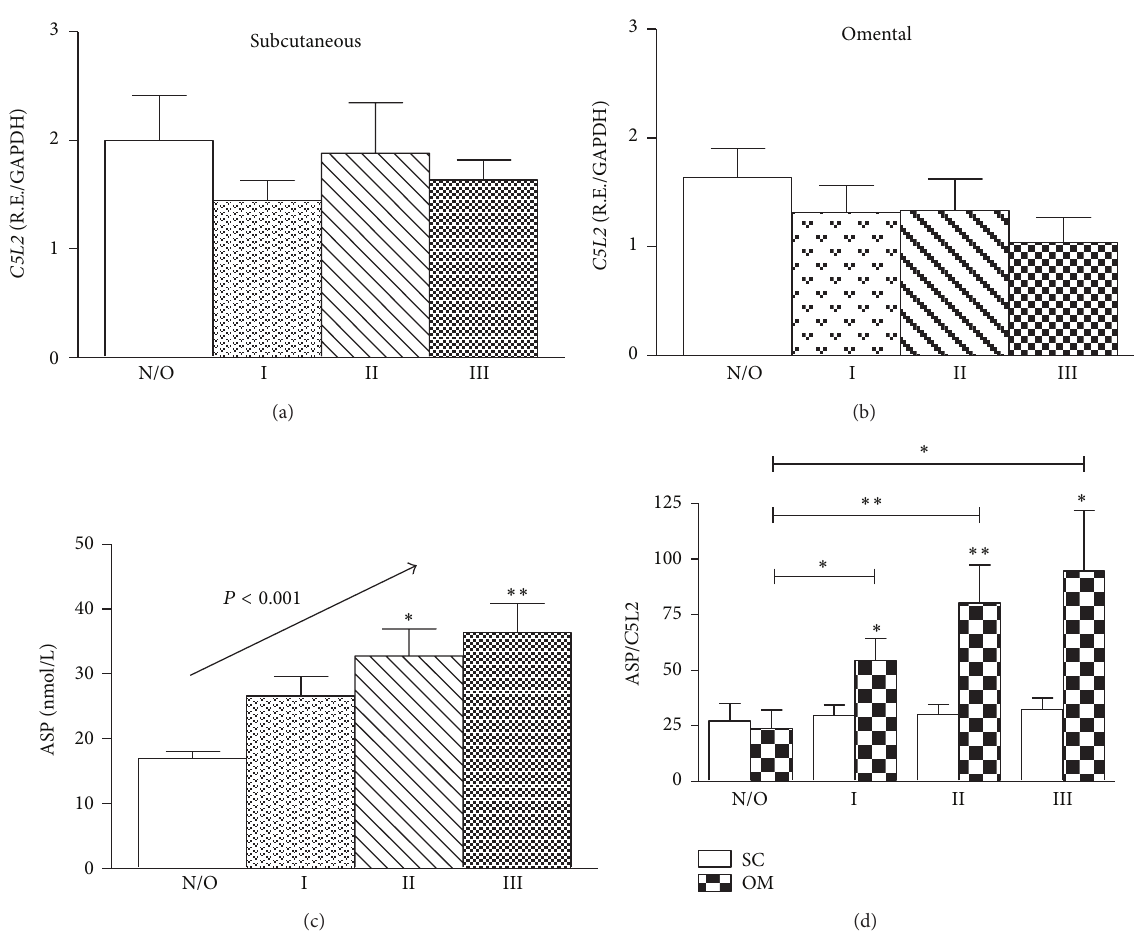
Figure 1: Circulating ASP and ASP to C5L2 ratio are associated with adiposity. Subcutaneous (a) and omental (b) C5L2 mRNA expression for normal/overweight (open bar), obese group I (dotted bar), obese group II (striped bar), and obese group III (checkered bars), (c) plasma ASP for normal/overweight (open bar), obese group I (dotted bar), obese group II (striped bar), and obese group III (checkered bars), and (d) ASP/ C5L2 ratio in subcutaneous adipose tissue (open bars) and omental adipose tissue (checkered bars). Results are expressed as means ± SEM; 𝑛 = 33–36 per group. Statistical differences were determined by Student’s 𝑡 -test and one-way ANOVA, for normal/overweight versus obese groups and for SC versus OM groups, where ∗ 𝑃 < 0.05 and ∗∗ 𝑃 < 0.001 .